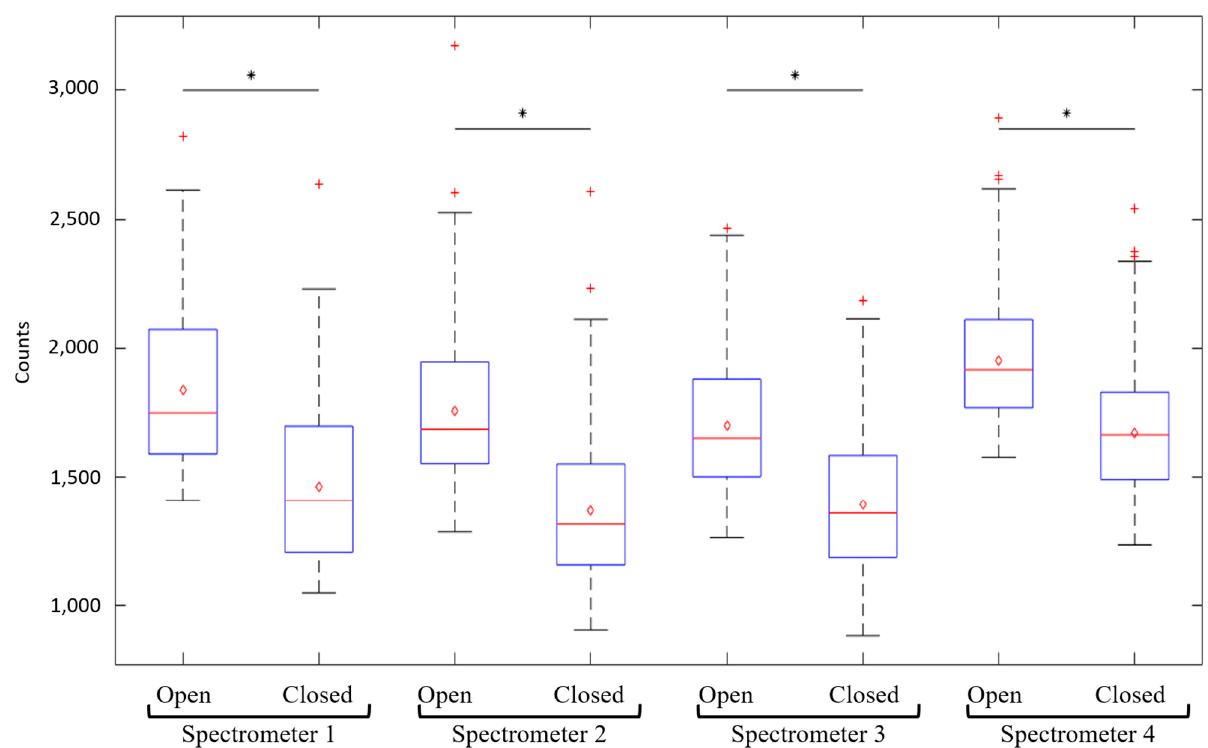
Figure 5. Boxplot ( n = 5) of the photon count values measured for background (spectrometer’s entrance left “open” connected to the collection fiber) and dark (spectrometer’s entrance “closed” with a black cap) noises for each of the four spectrometers used on the SpectroLive device. Stars indicate significant statistical differences.